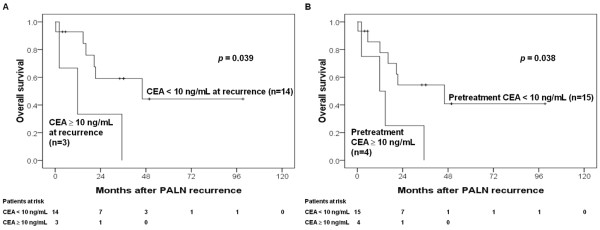
(A) CEA ≥ 10 ng/mL at recurrence and (B) pretreatment CEA levels predicted overall survival after isolated PALN recurrence.